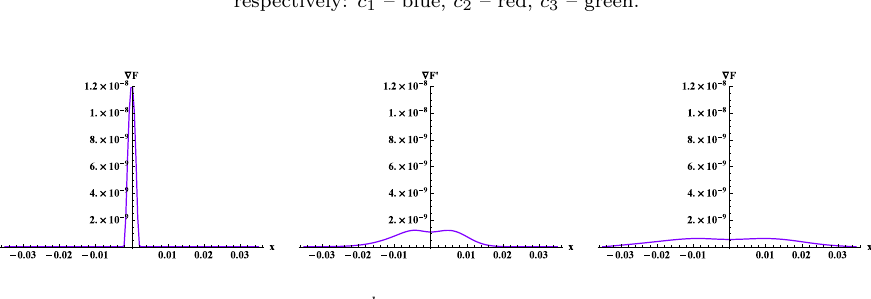
Figure 1. Distributions of concentrations c i ( i = 1 , 2 , 3) for the times 0, 7 and 28 days respectively: c